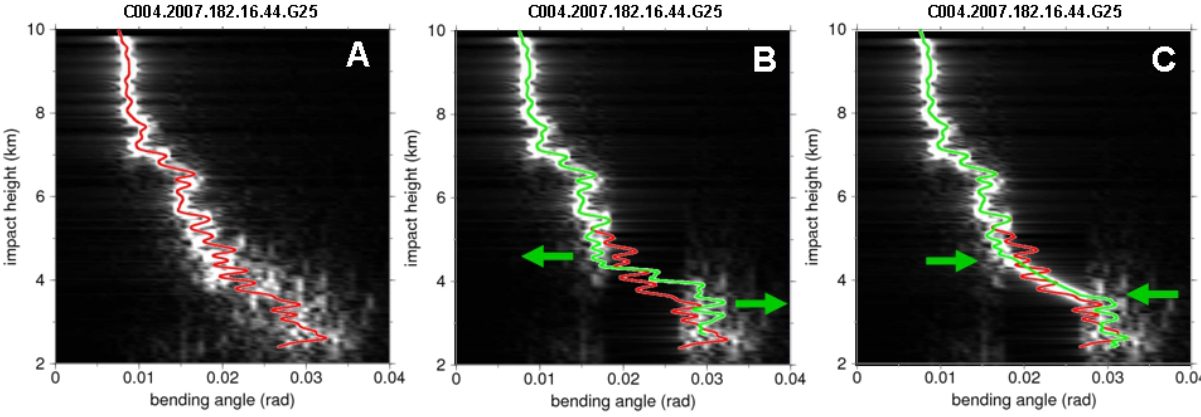
Fig. 11. Sliding spectrograms of F3C RO signals transformed to impact parameter representation (gray scale) and retrieved bending angle profiles (color lines) for F3C tropical occultation. Red and green lines correspond to bending angle retrieved from original signal and with artificially introduced gap. For details see text.